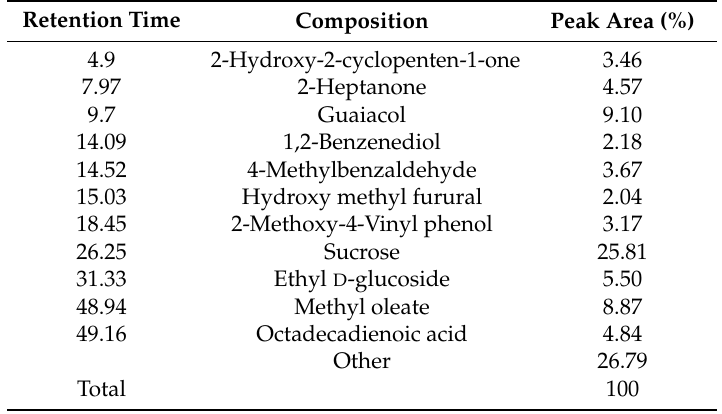
Table 3. The major compounds of the extract of Chenopodium formosanum